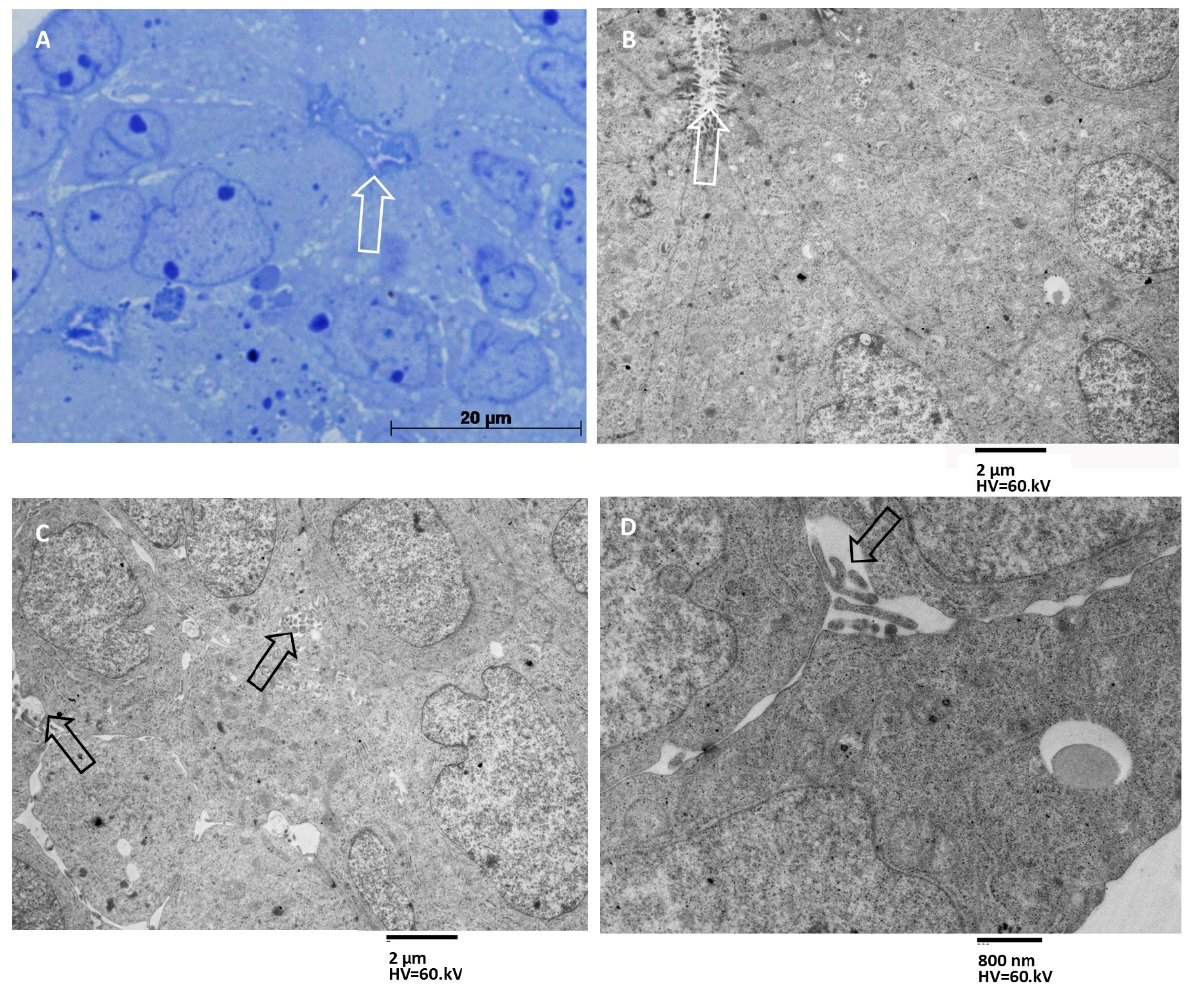
Figure 3. MTSs of group B. ( A ) Light microscopy image of a three-layered spheroid containing a pseudocyst-like structure (lumen pointed at by an arrow). Magnification 400×, bar 20 µm. ( B ) TEM image shows that cells lining the lumen of the pseudocyst are tightly adhered to each other, possess microvilli on the apical surface, and secrete exosomes in the lumen (white arrow). Magnification 1250×, bar 2 µm. ( C ) Cells of the outermost layers are adherent to each with just narrow intercellular spaces (black arrows). Magnification 1250×, bar 2 µm. ( D ) Finger-like cells’ membrane eversions into the narrow intercellular spaces are shown, and no exosome secretion is present. Magnification 4000×, bar 800 nm.